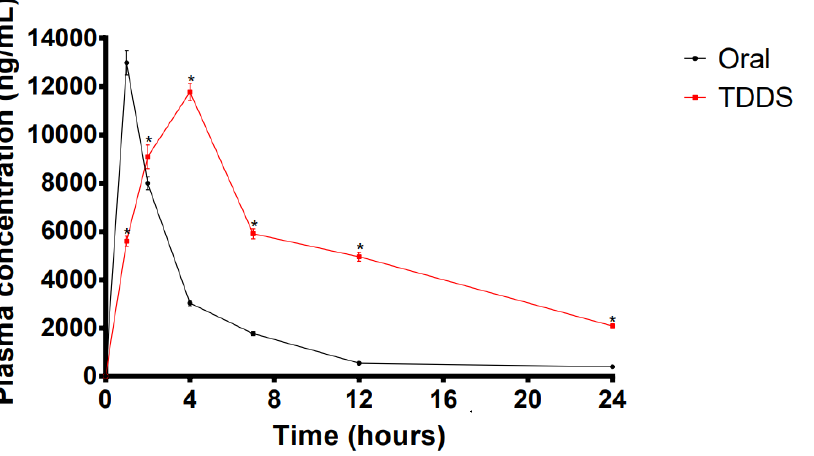
Figure 5. Plasma drug concentration-time curve analysis in rabbits after LP-VPH compound trans- dermal drug delivery system and oral administration (mean ± SD, n = 6, * p < 0.05, compared with the corresponding time points oral administration). Table 3. Pharmacokinetic parameters (n =